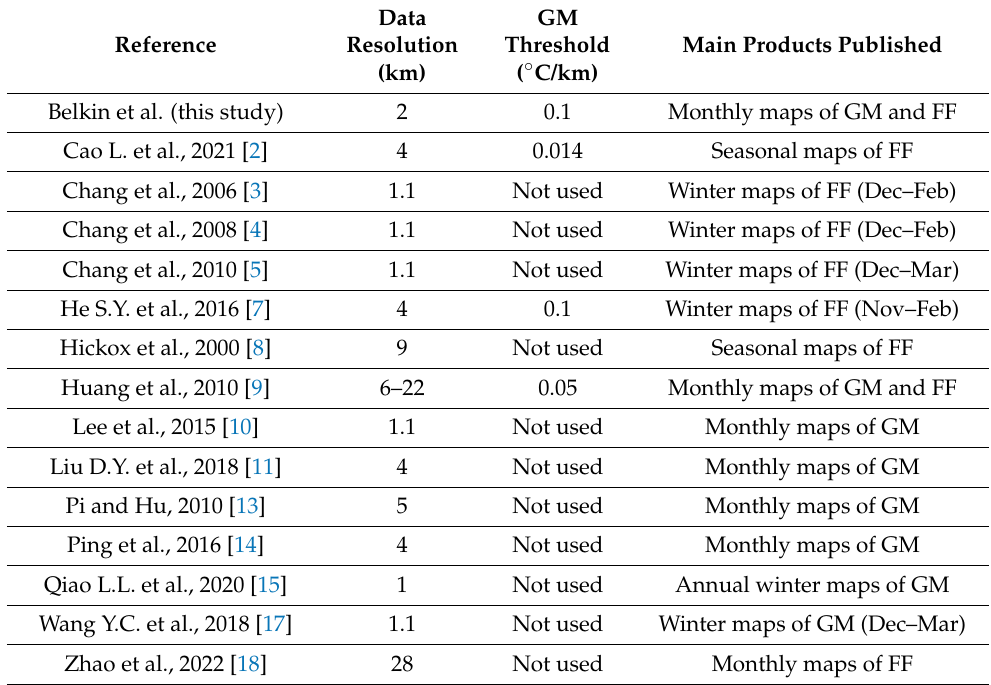
Table 6. Satellite studies of SST fronts off the Zhejiang-Fujian